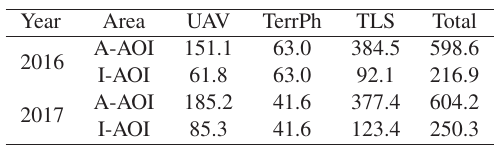
Table 3. Number of points (millions) acquired by the employed 3D acquisition techniques within the two areas of interest.